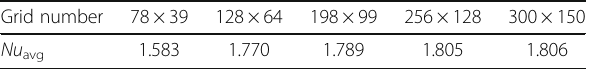
Table 2 Grid independence test. Numerical simulation results